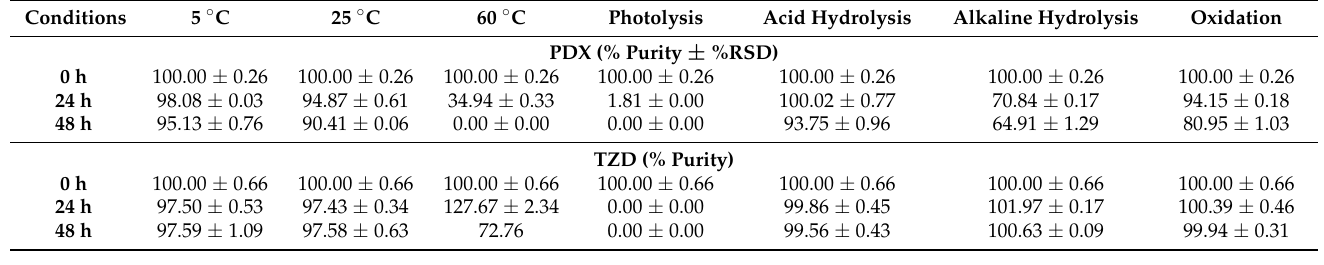
Table 6. Percentage purity (%) calculated for PDX and TZD during exposure to various storage conditions as well as harsh environments for a period of three days.